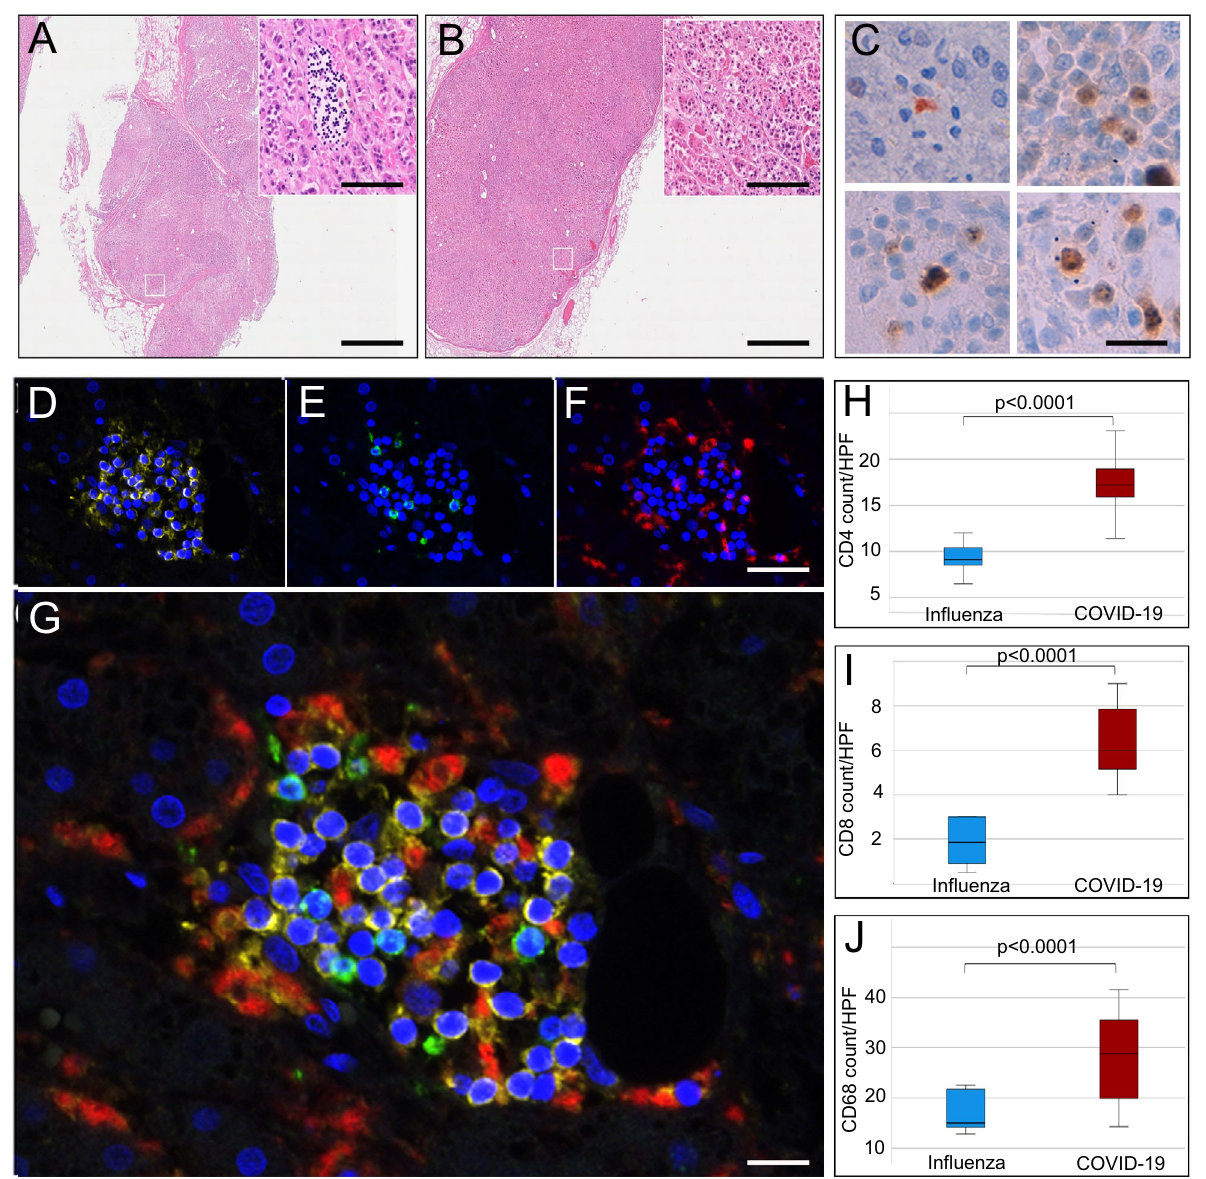
Fig. 3 In fl ammation of adrenal glands from patients who died of COVID-19 or in fl uenza. H&E sections of adrenal glands of COVID-19 patients ( A ) and in fl uenza patients ( n = 30) ( B ) (overview scale bar = 800 µ m and magni fi ed inlet scale bar = 50 µ m) reveal lymphohistiocytic in fi ltrate in the adrenal cortex of COVID-19 patients. Multiplex immuno fl uorescence of adrenal glands ( n = 19) ( D – G , scale bar = 50 µ m) shows that in fi ltrates consisted of CD4 ( D , yellow), CD8 ( E , green), and CD68 ( F , red) positive cells (DAPI counterstain in blue). Box and Whisker plots ( H , I ) display lower quartile, upper quartile, and median bounds of cohort expression at the box ’ s minima, maxima, and centerlines, respectively. Whisker lines display lower (bottom) and upper (top) extreme value ranges. p values were calculated by an unpaired two-sided Student ’ s t- test. Source data are provided as a Source Data fi le. Quanti fi cation of cell types reveals a signi fi cantly higher number ( p < 0.0001) of CD4 ( H ), CD8 ( I ), and CD68 ( J ) positive cells in patients with COVID-19 compared to in fl uenza. In the center of in fl ammatory in fi ltrates ( n = 19) single-cell apoptosis could be detected by immunohistochemistry of cleaved caspase 3 ( C , scale bar corresponds to 10 µ